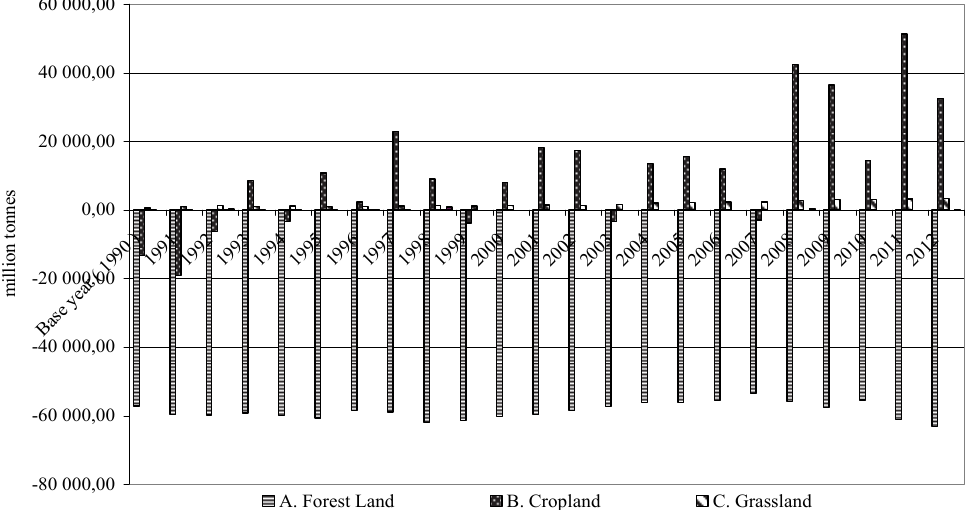
Fig. 2. Changes in carbon uptake in Ukraine (National Cadastre of anthropogenic emissions from sources and absorption of greenhouse gases absorbers in Ukraine in